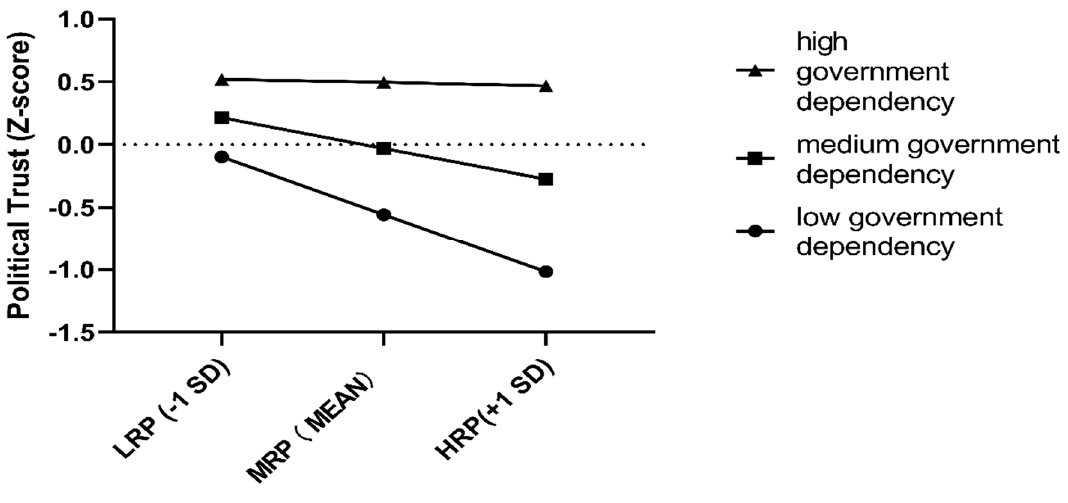
Figure 2. The interaction effect of risk perception and government dependency on political trust.